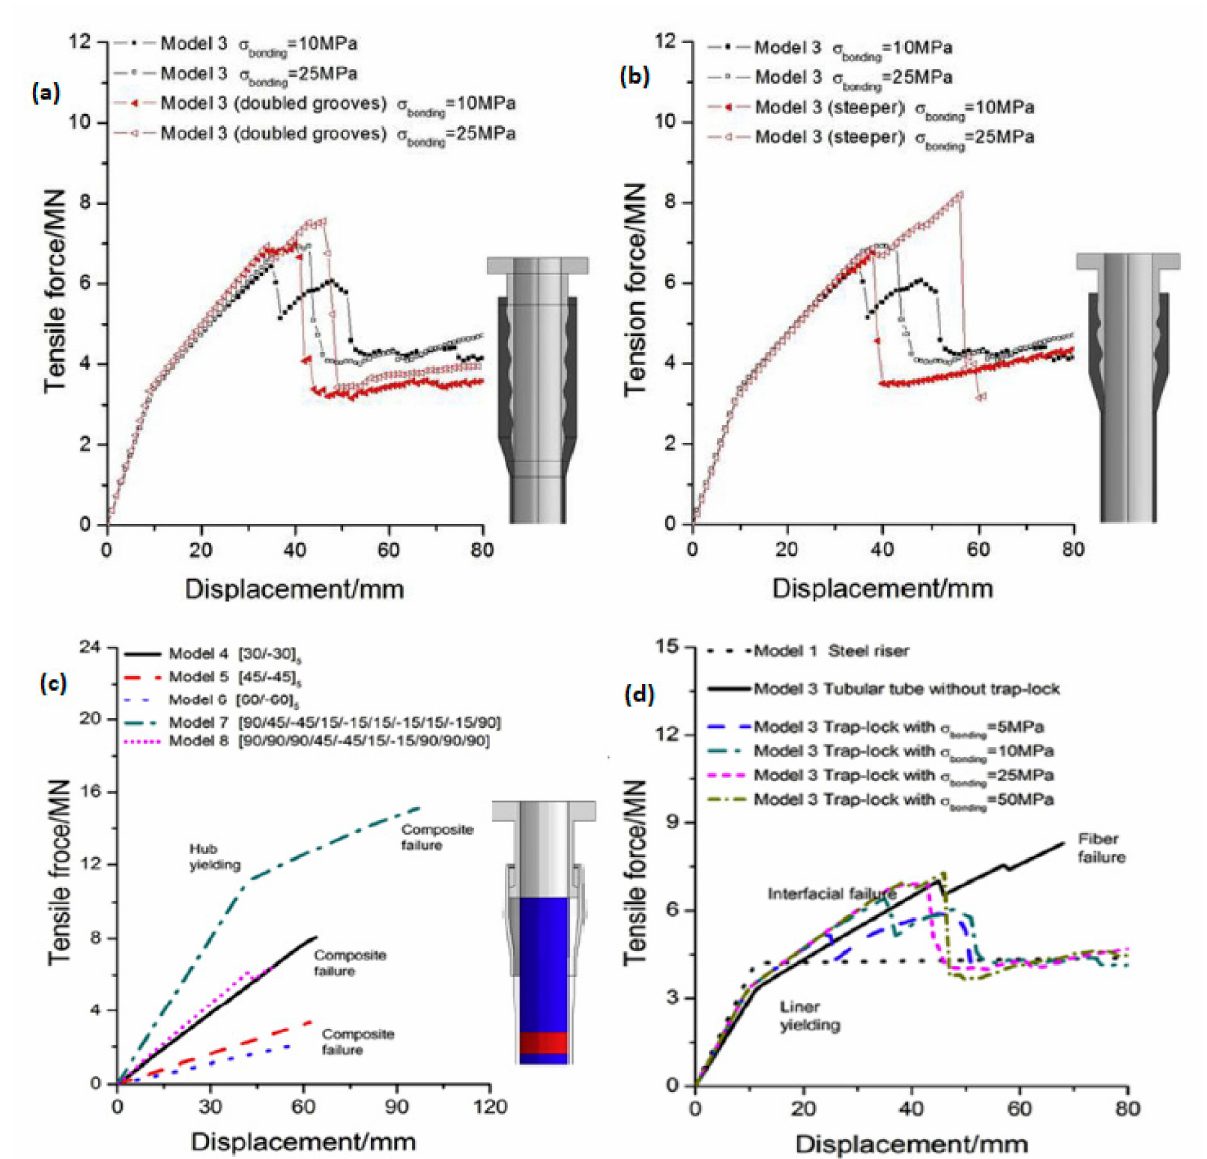
Figure 13. Results of displacement vs. force profiles for different models with load transfer mecha- nism of traplock and Magma end-fitting models, to present the failure profiles from tension loads on the body of the composite riser pipe. It shows the displacement-force curves of ( a ) trap-lock end fittings with doubled number of grooves, ( b ) trap-lock end fittings with steeper grooves, ( c ) Magma end fitting model with different composite laminates, and ( d ) trap-lock end fitting with steel riser and other composite risers. (Permission to reuse was obtained from Elsevier Publishers, Source: [187]; Published: 4 June 2018; Copyright date: